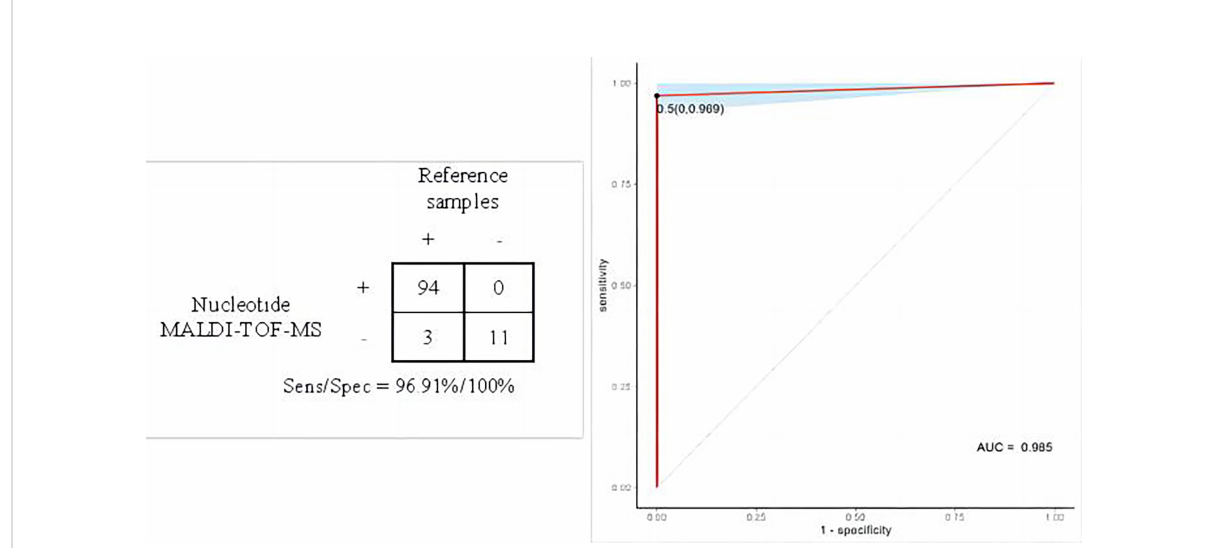
FIGURE 2 Performance evaluation of nucleotide MALDI-TOF-MS in the identi fi cation of mycobacterial species.